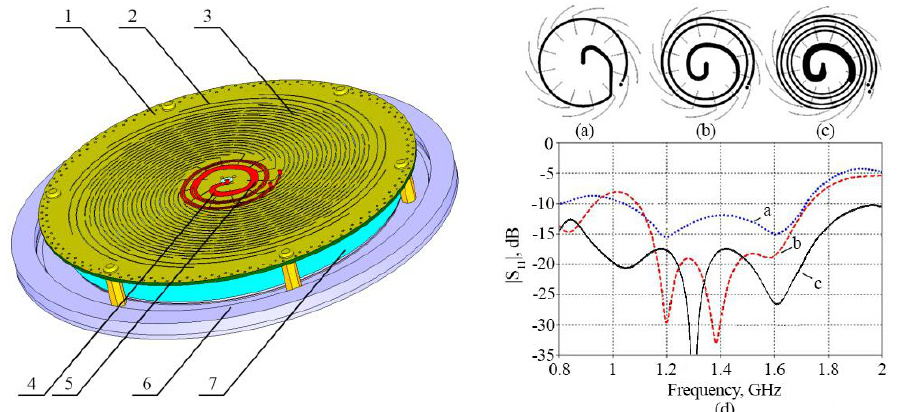
Fig. 1. Simulation model of the designed antenna. Fig. 2. (a) and (b) are the well-known MSL, (c) MSL of the designed antenna, (d) Simulated input reflection